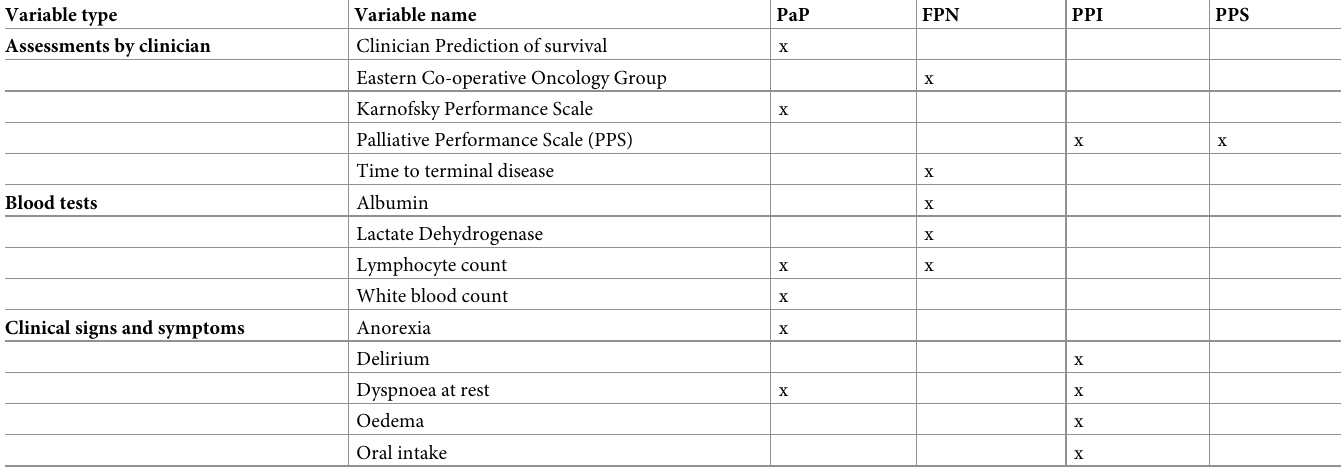
Table 1. Variables required for the calculation of each prognostic